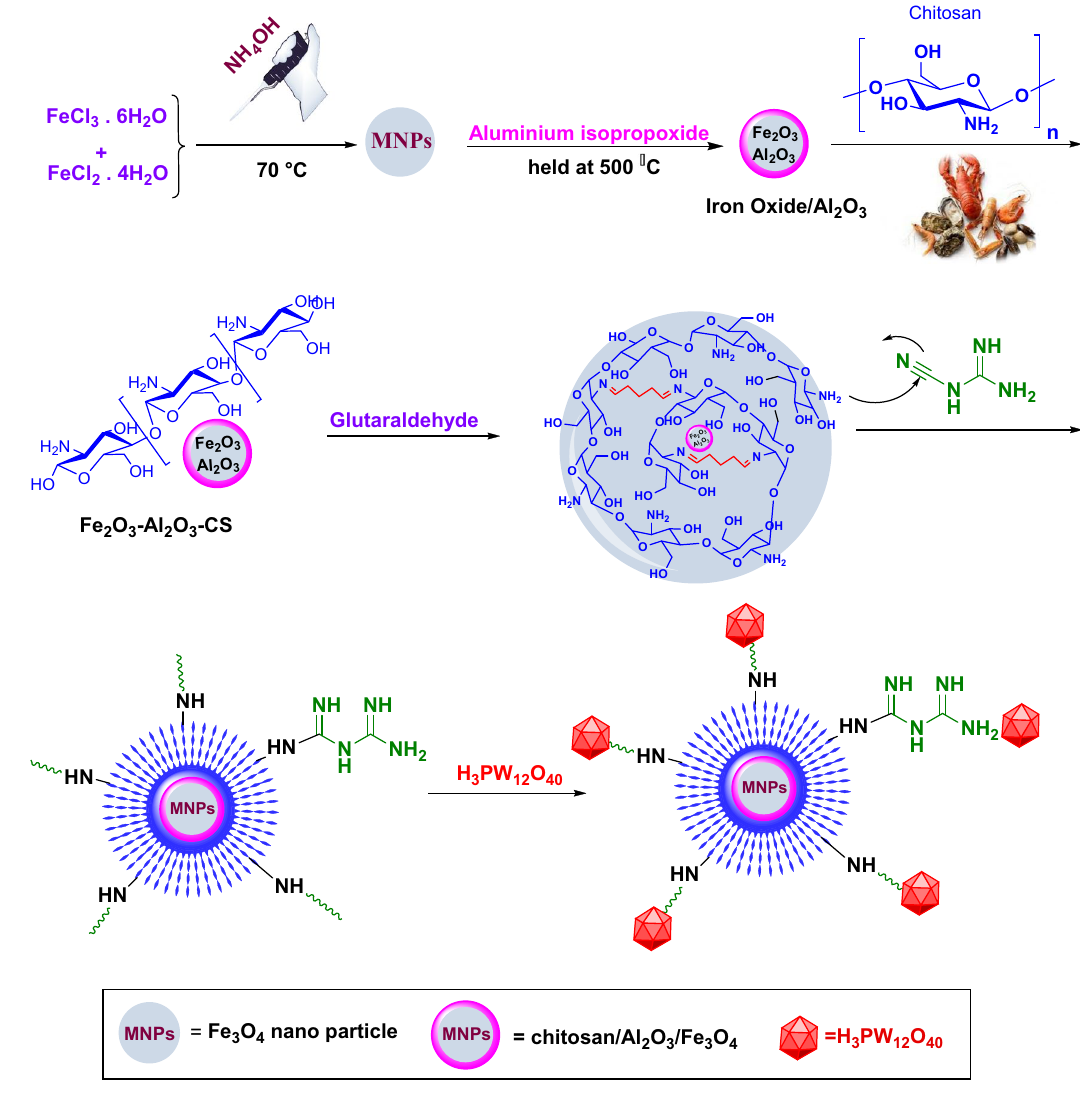
Figure 2. The representation of the fabrication of HPA@Fe 3 O 4 –Al 2 O 3 /CS–CG.